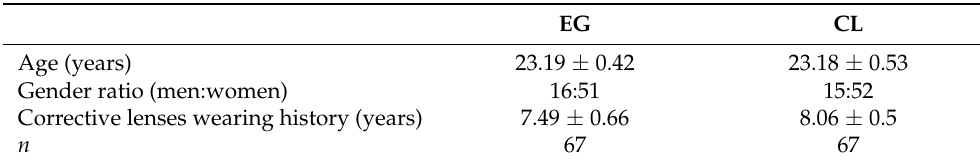
Table 1. Characteristics of the eyeglasses (EG) wearers and soft contact lens (CL) wearers participating in the